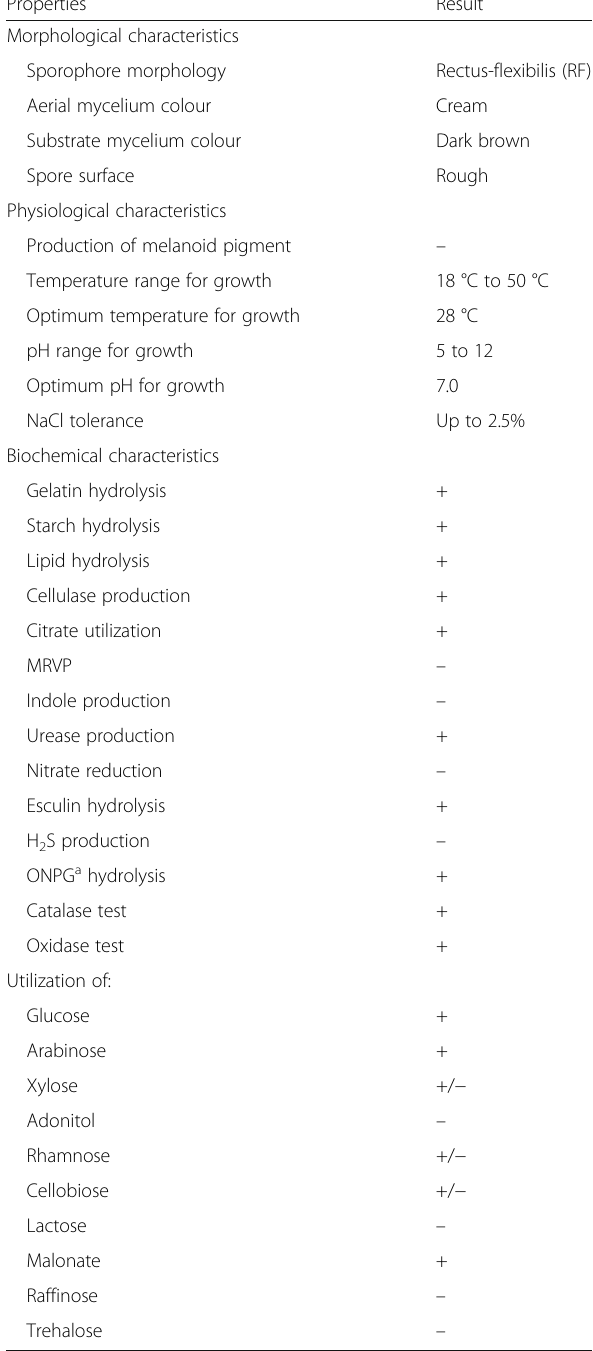
Table 2 Morphological, physiological and